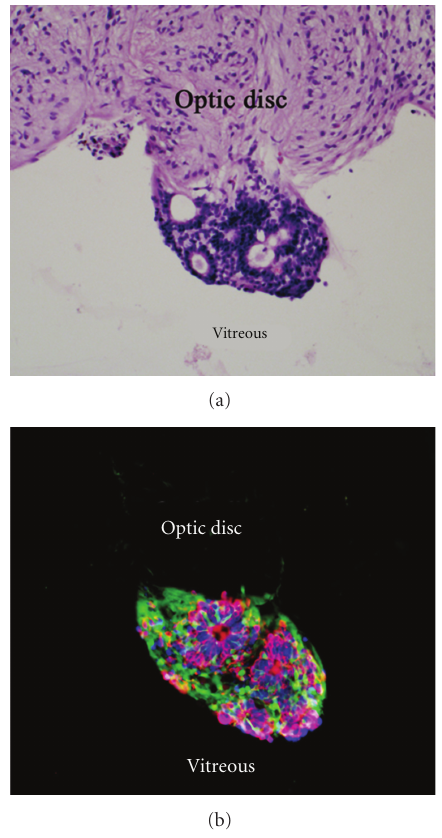
Figure 4: Grafted cells form rosettes and express photoreceptor markers. Recipient was 6 weeks of age at time of transplantation and experiment terminated 5 weeks later. The H&E section (a) shows a cluster of grafted cells adhering to vitreal surface of the host optic nerve head, likely a result of reflux around the time of surgery. This cluster contains multiple rosettes of the type formed by photoreceptor cells, with darkly staining nuclei densely packed in a peripheral rim and lighter staining material in the rosette’s core. Fluorescence imaging (b) confirms the cluster to be GFP+ and therefore of donor origin. Immunolabeling for rhodopsin (red) and recoverin (blue) demonstrates photoreceptor marker expression by a subset of grafted cells. Cells expressing photoreceptor markers are predominantly found within